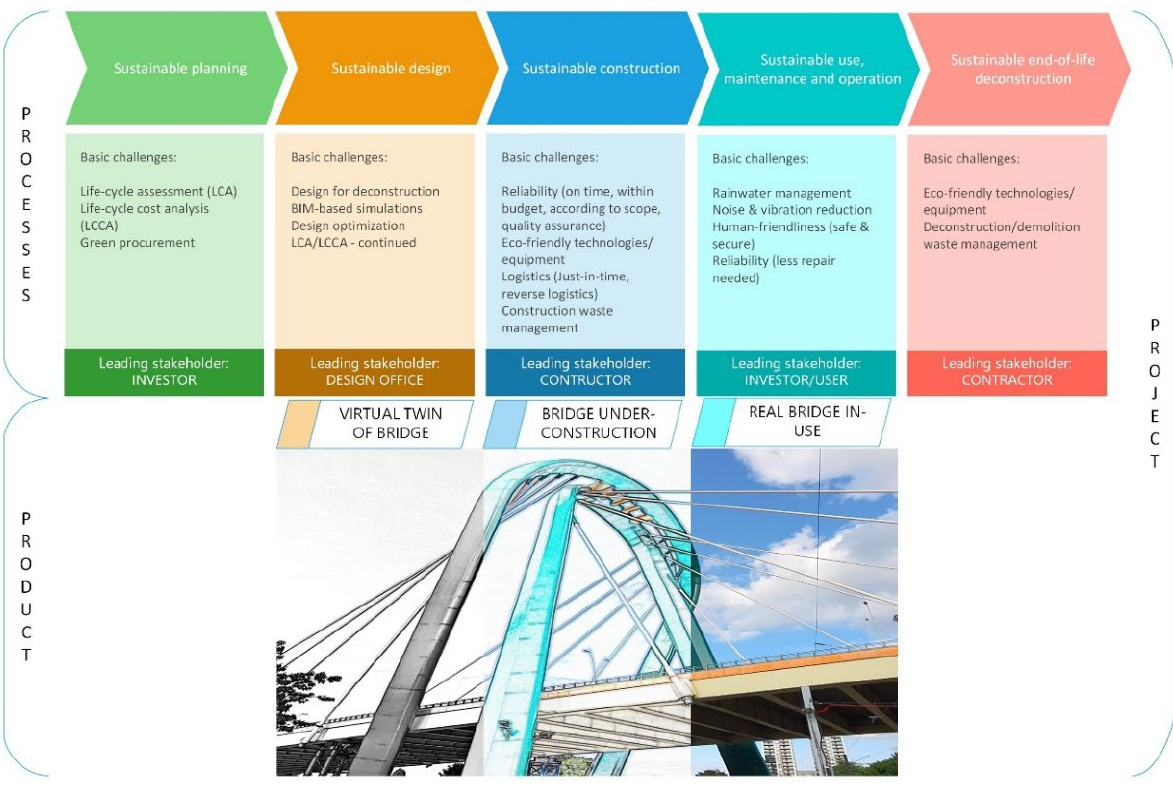
Figure 8. Sustainable bridge construction project model.